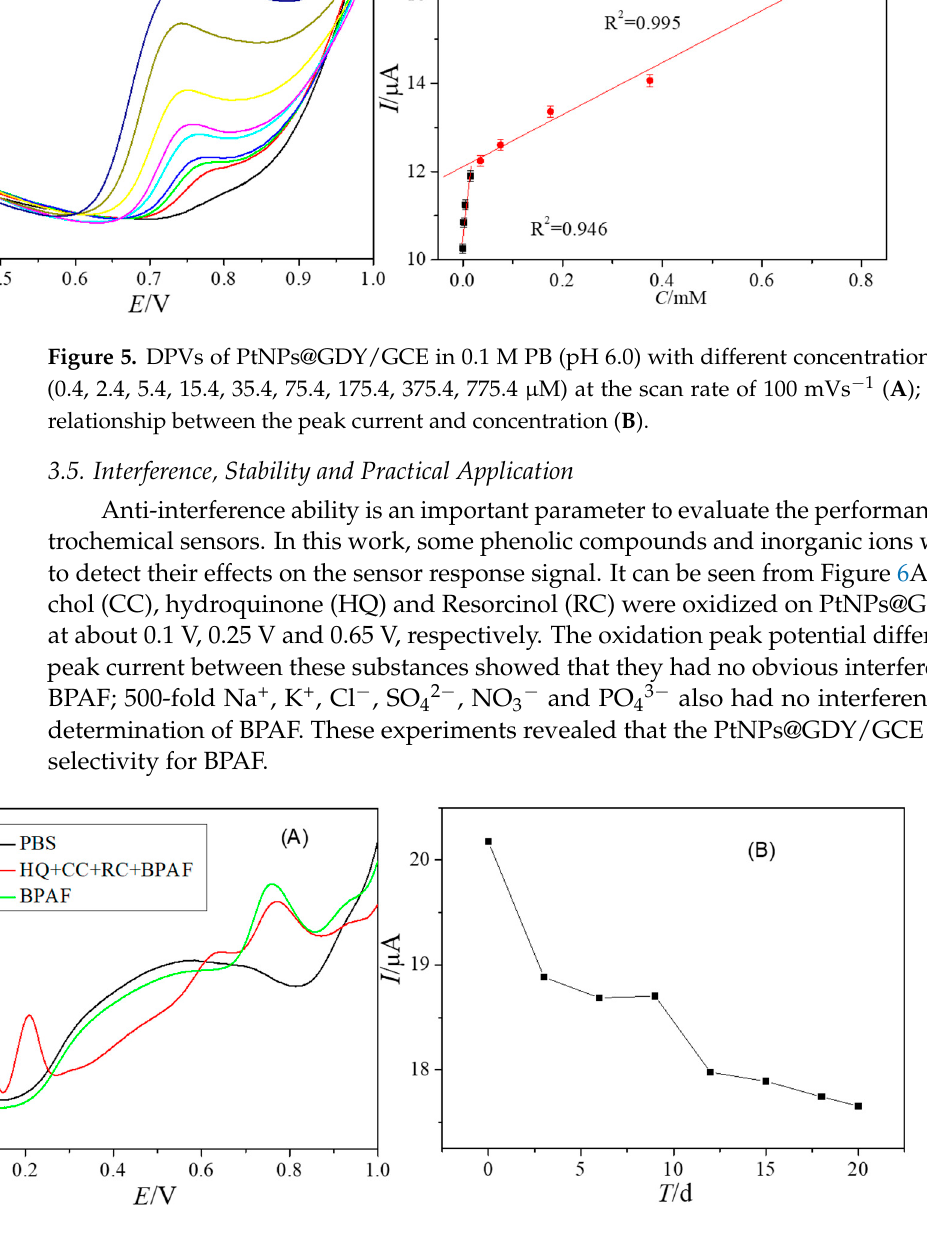
Figure 5. DPVs of PtNPs@GDY/GCE in 0.1 M PB (pH 6.0) with different concentrations of BPAF